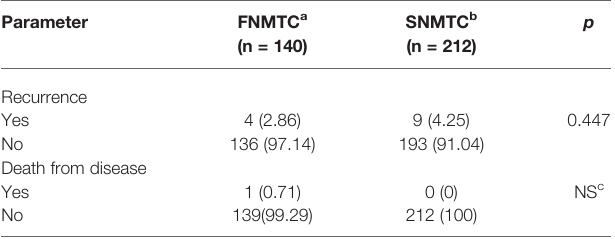
TABLE 2 | Recurrence and mortality of FNMTC versus SNMTC, n (%).